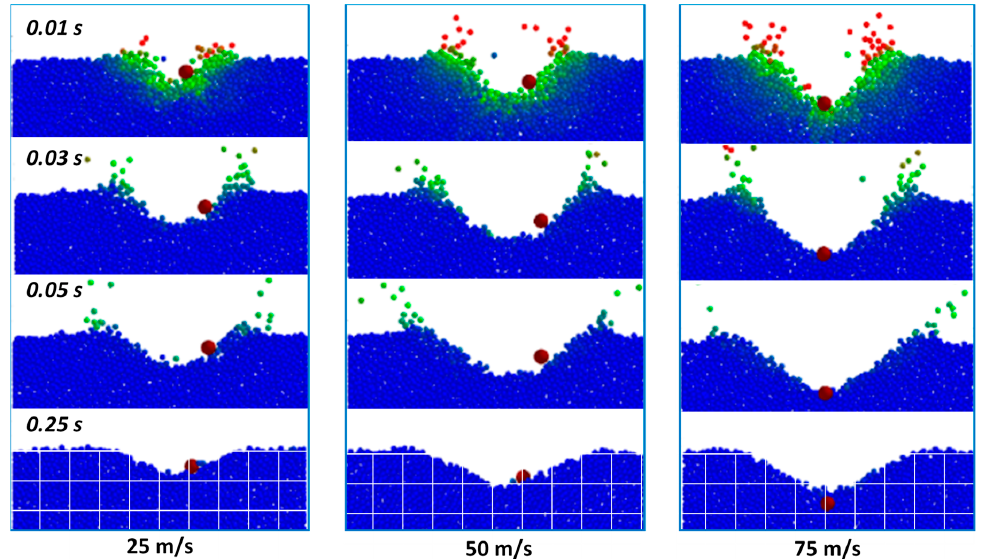
Figure 18. The process of seed penetration into loosely cohesive soil at different